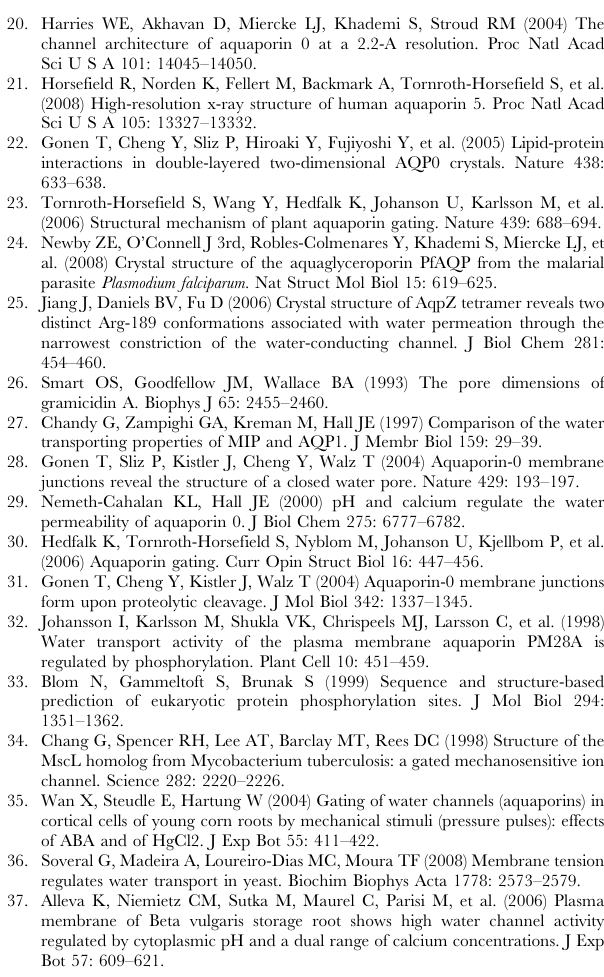
Figure S10 Crystals of Aqy1 from pH 3.5 and 8.0. (A) shows Crystal 1 (pH 3.5, 1.15 A˚ ) and (B) shows Crystal2 (pH 8.0, 1.4 A˚ ). Figure S11 Western blot of P. pastoris membrane fractions used for the spheroplast water transport assay showing the expression levels of the respective proteins.